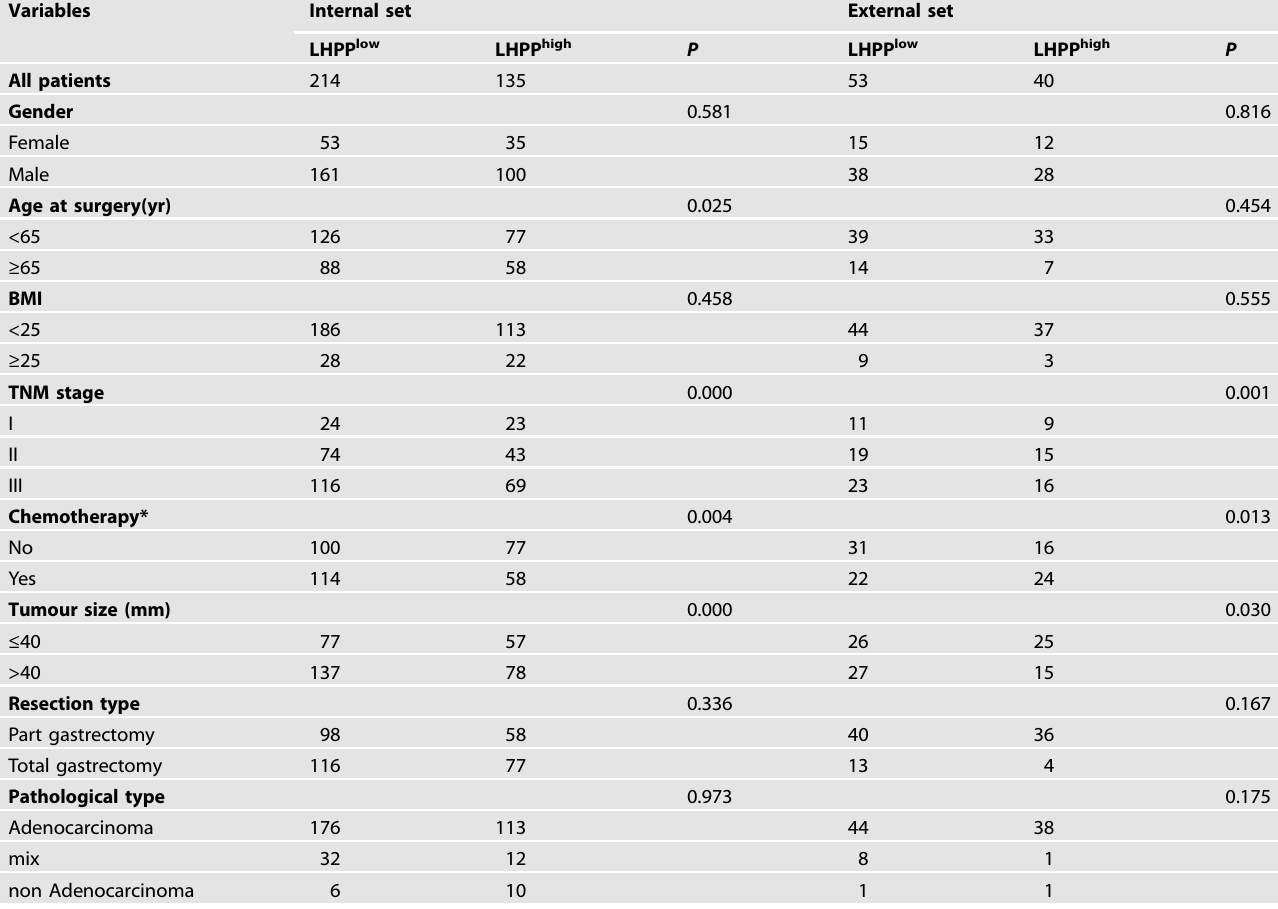
Table 1. Relationship between LHPP expression and baseline characteristics of